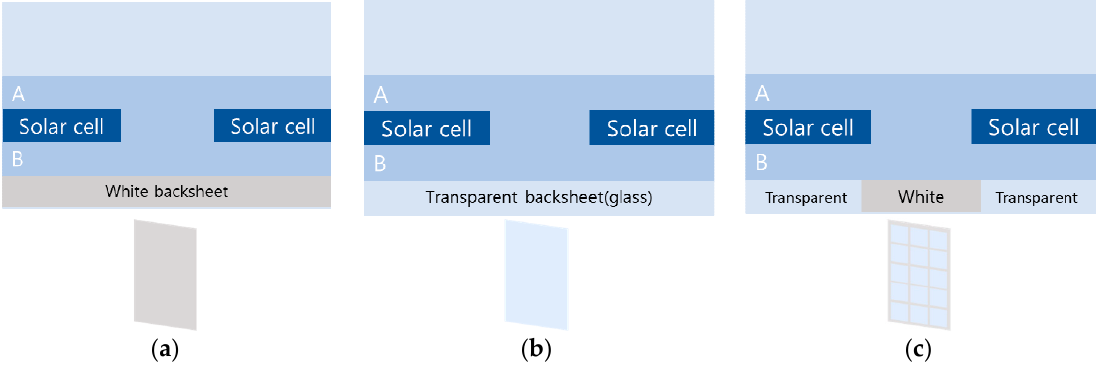
Figure 1. Overview on different module designs: ( a ) glass–backsheet; ( b ) glass–glass; ( c ) glass–meshed backsheet.